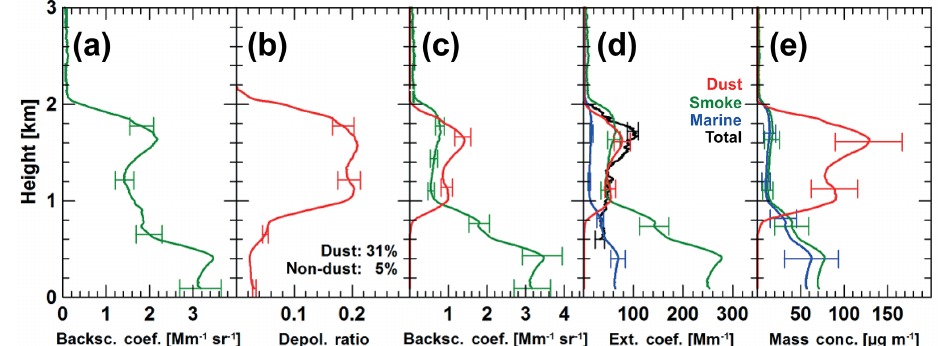
Figure 2. Shipborne lidar observations of the Saharan air layer (SAL, 800–2000m height) above the marine aerosol layer (MAL) on 5– 6 May 2013, 23:40–00:35UTC (see Fig. 1, case 4): (a) 532nm particle backscatter coefficient, (b) 532nm particle linear depolarization ratio, (c) non-dust (green) and dust (red) particle backscatter coefficients, (d) dust extinction coefficient (red) and non-dust extinction coefficients (blue if the non-dust component is of marine origin, lidar ratio of 20sr; green if the aerosol component is, e.g., biomass burning smoke and anthropogenic haze, lidar ratio of 50sr), and (e) dust (red) and non-dust mass concentration (blue if marine; green if smoke and haze). Error bars indicate the retrieval uncertainties (1 standard deviation). The black curve in panel (d) is the total particle extinction coefficient independently determined by means of the Raman lidar